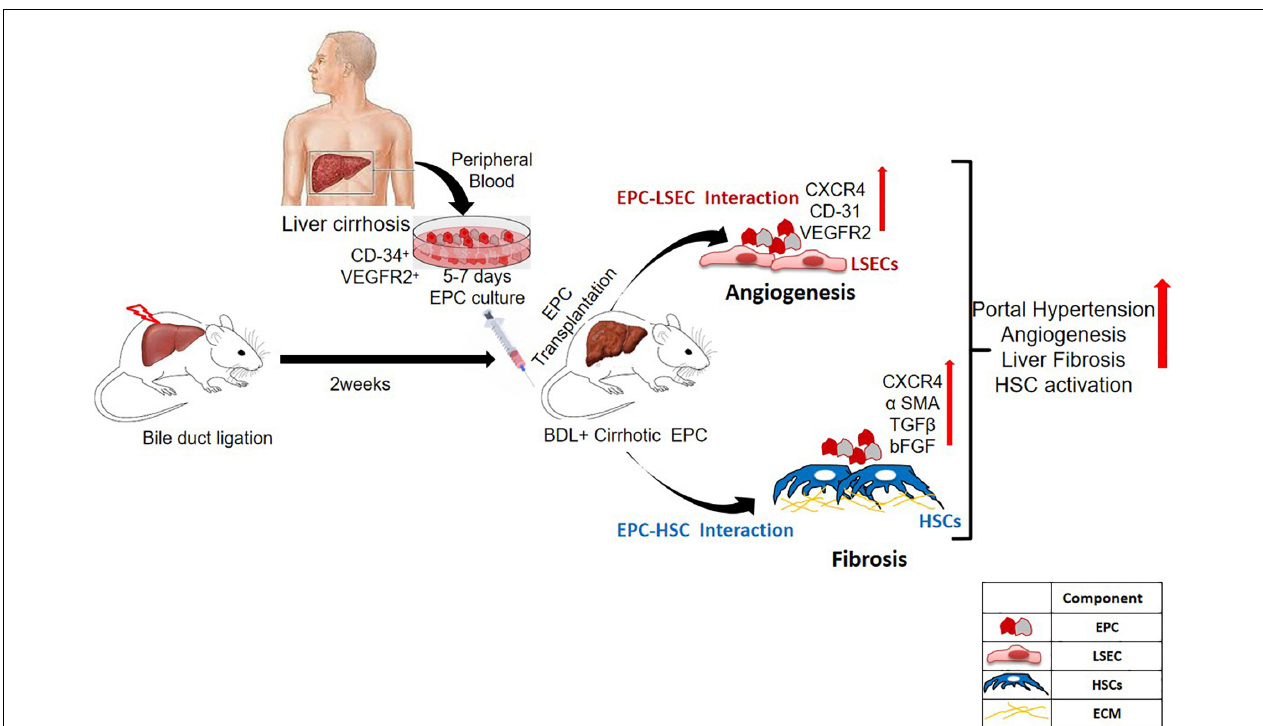
FIGURE 8 | Overall summary of the study. Transplantation of cirrhotic EPCs (CD34+-vegfr2+) in BDL rats interacts with LSECs and HSCs in vivo and increases hepatic angiogenesis, and fibrosis further aggravates portal